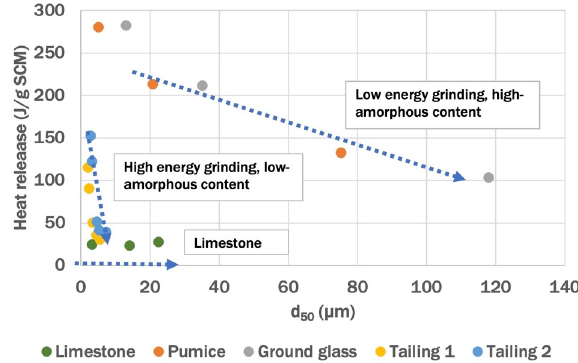
Figure 5. Influence of fineness on heat release using the modified R 3 test (adapted using data from [31,32]).